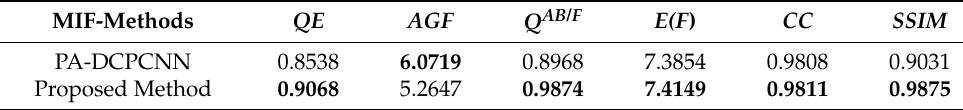
Figure 9. Multi-focus image of a clock from various perspectives. Original Image: ( a ), Multi-focus Input Images: ( b , c ), and Proposed Fusion: ( d ). Table 3. The results and comparisons for clock image ([20]).